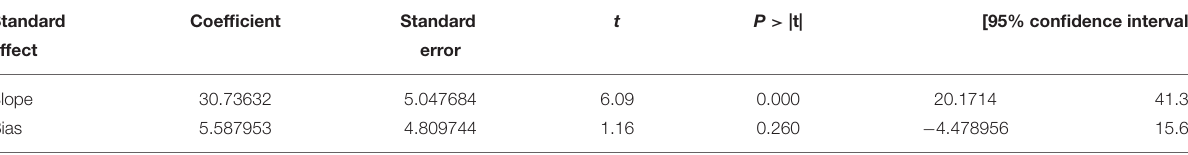
TABLE 4 | Egger’s test for small study effects.